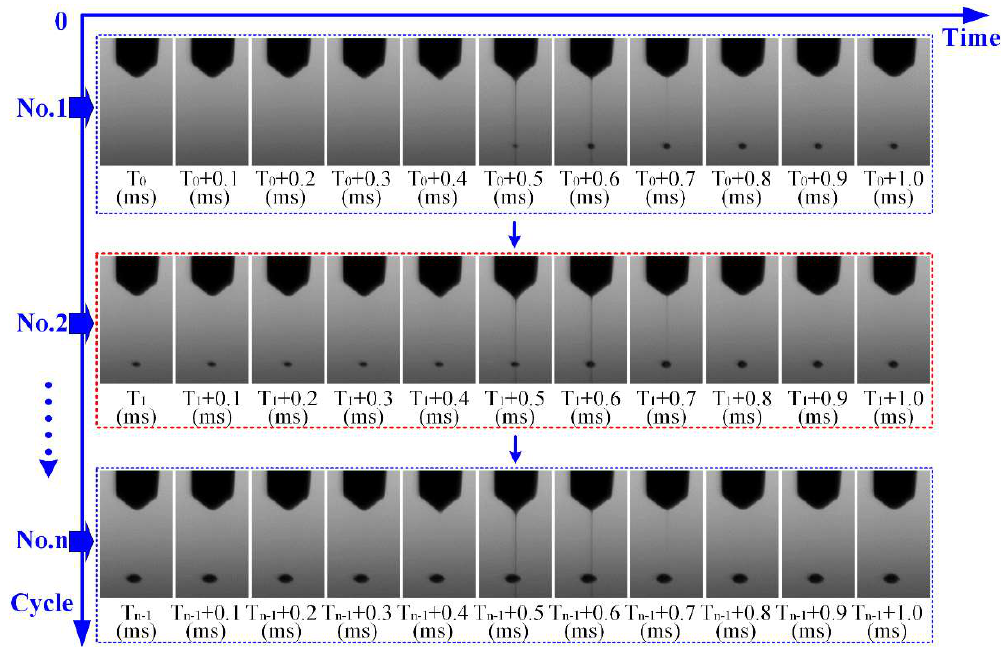
Figure 7. Image sequences of E-jet printing process in multiple cycles.